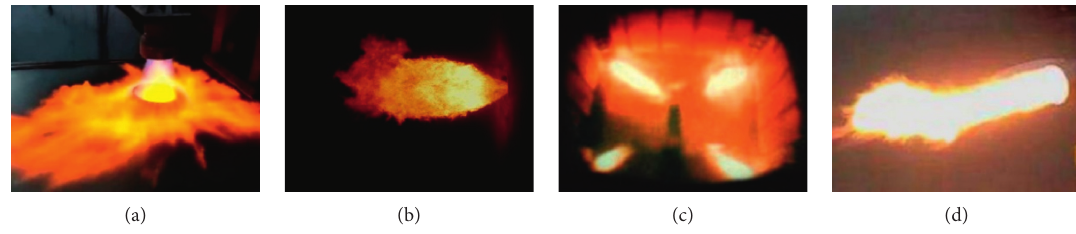
Figure 1: The four flame images of different combustion states: (a) I; (b) II; (c) III; (d) IV.